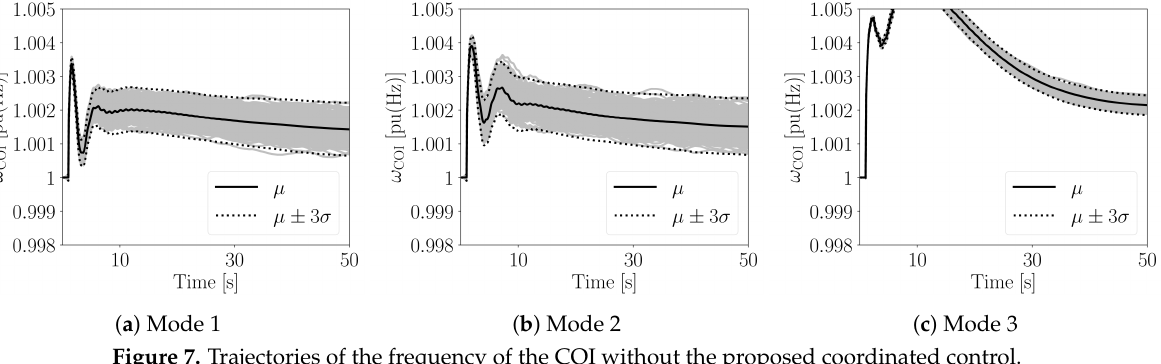
Figure 7. Trajectories of the frequency of the COI without the proposed coordinated control. Table 1. Mean frequency µ COI and standard deviation σ COI for different VPP control